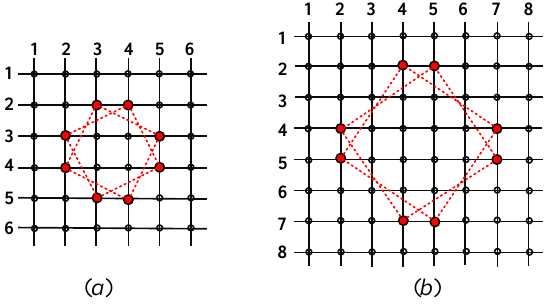
Figure 13. Center rule (K = 4): ( a ) 6 × 6 intersections; ( b ) 8 × 8 intersections. 4 RSUs, the road network is partitioned into four grids using